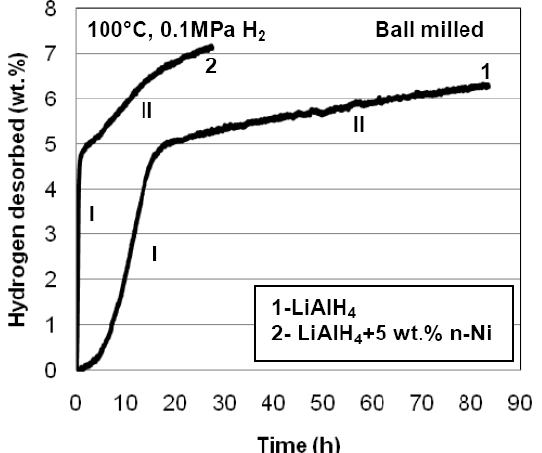
Figure 13. Comparison of volumetric desorption curves at 100 °C under 0.1 MPa H pressure for ball milled undoped LiAlH (curve 2). Adapted from